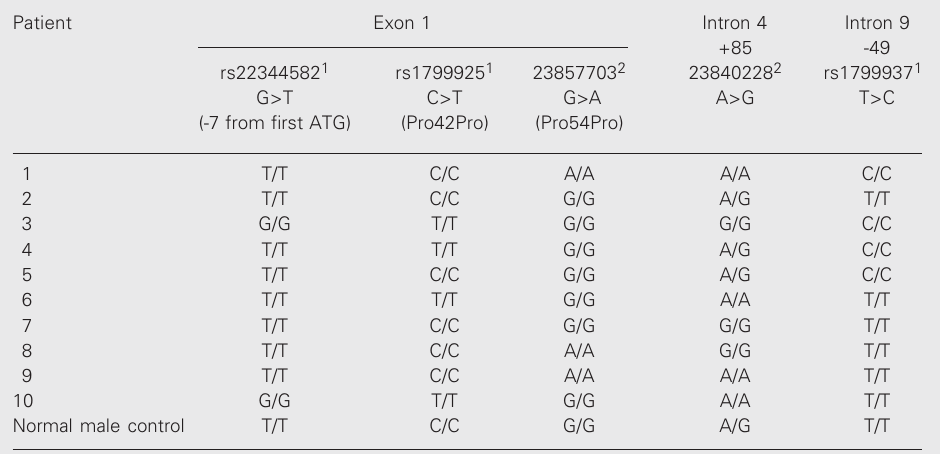
Table 3. WT1 single nucleotide polymorphism genotypes in 10 children with partial gonadal dysgenesis.